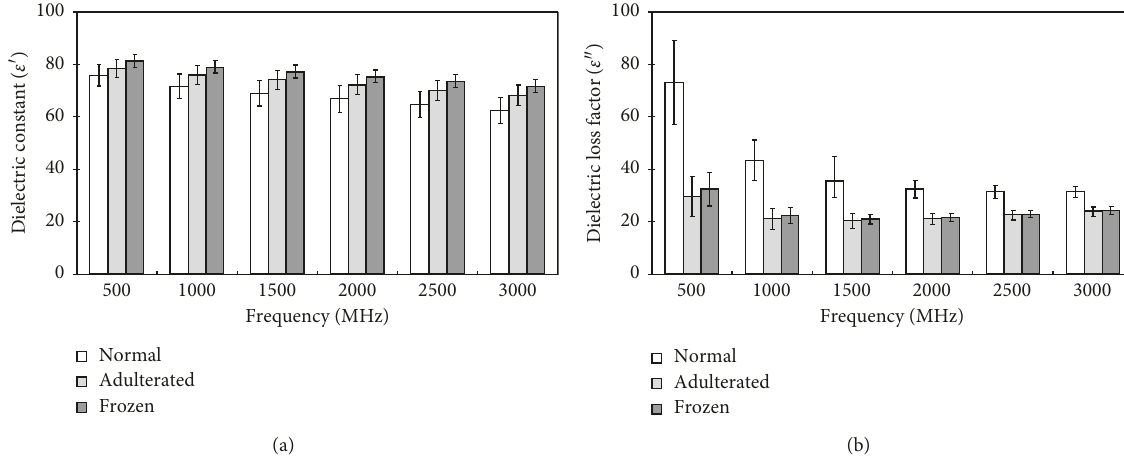
Figure 3: Dielectric properties of normal, adulterated, and imported frozen octopuses measured at the trunk part after thawing: (a) dielectric constant; (b) dielectric loss factor.